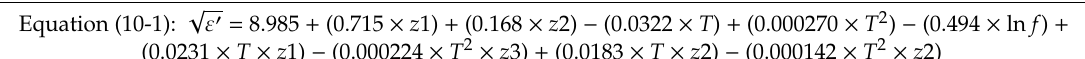
Table 10. Study of the e ff ect of three categories on the dielectric properties of cheese using regression